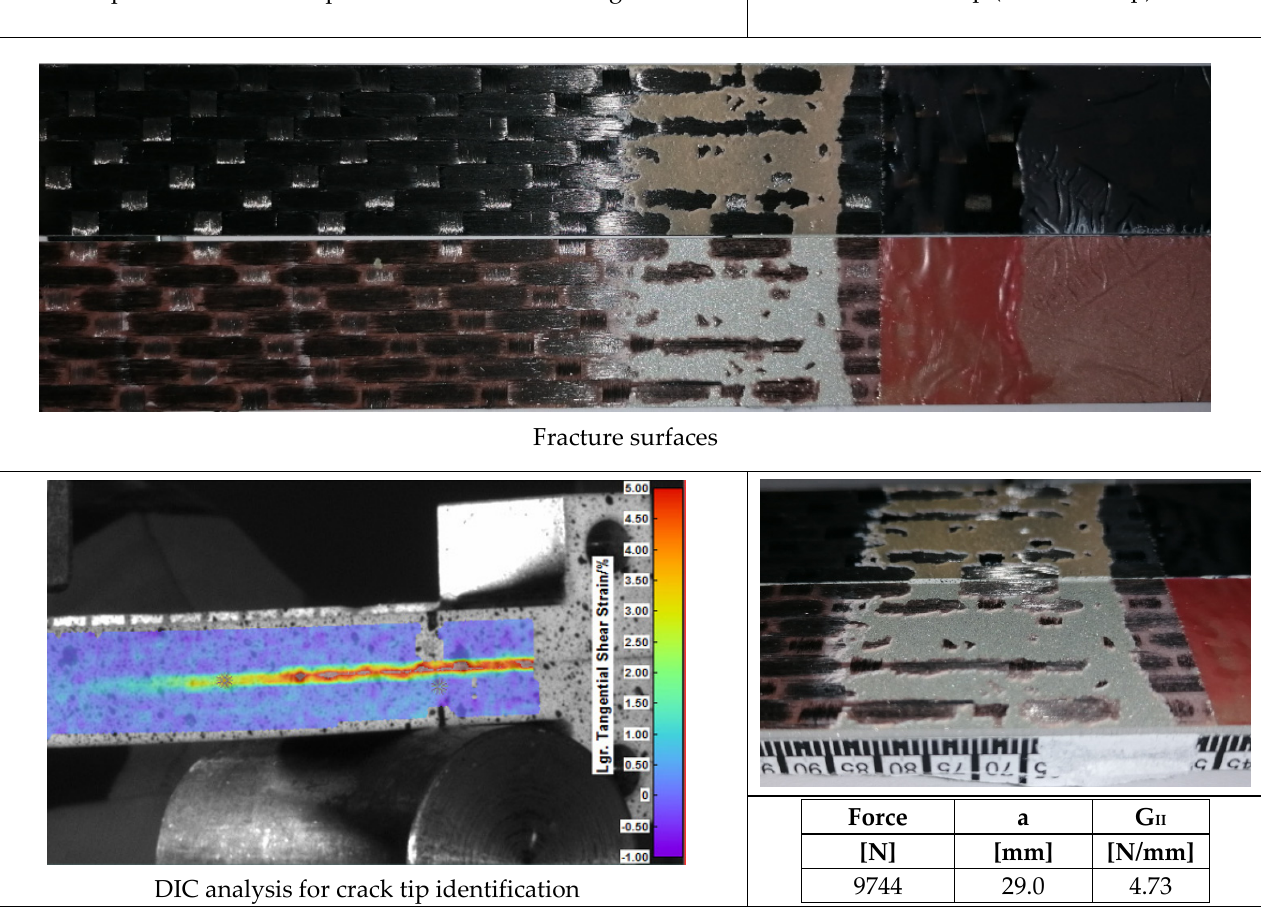
Figure 24. Results of the test on specimen ENF_9323_02.